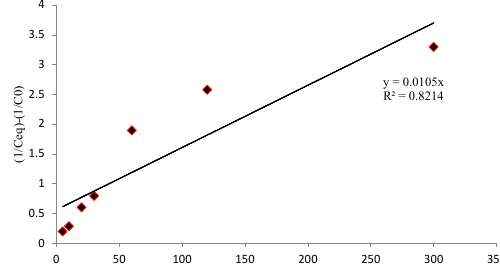
y = 0.0105x R²=0.8214